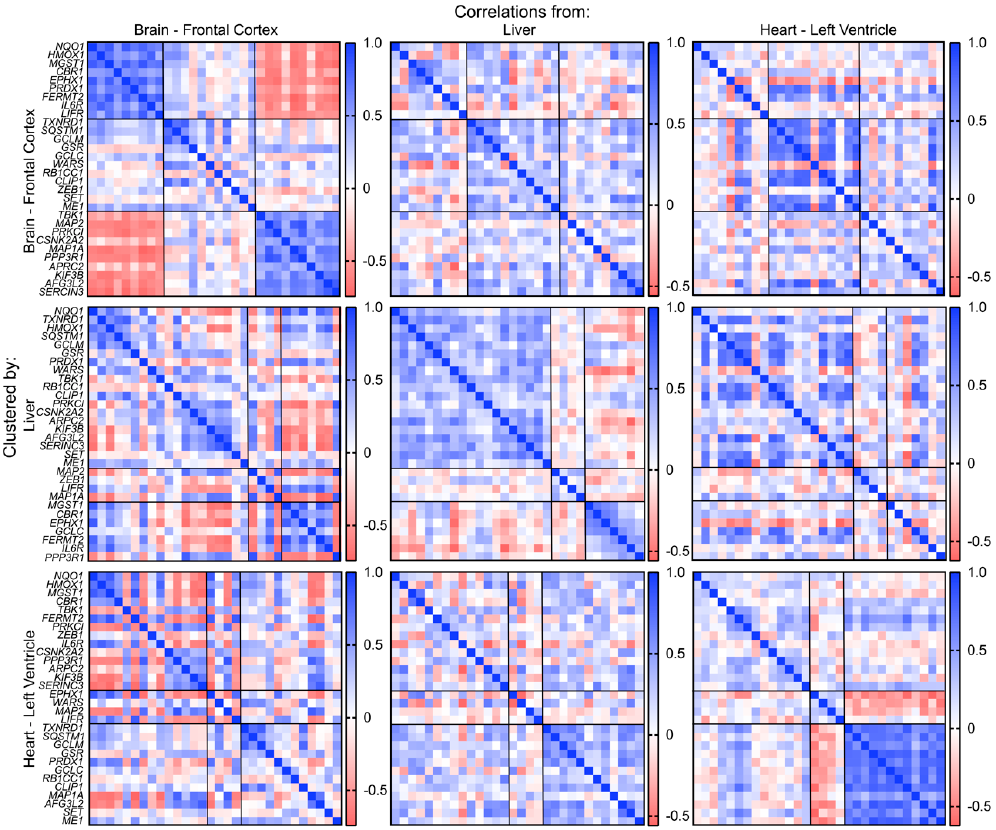
Figure 7. Co-expression patterns of NRF2 target transcripts in human tissues. Genes are separated into three groups by hierarchical clustering. First row: Correlation matrices of brain, liver, and heart clustered by the similarity of correlation patterns in the brain. Second row: Correlation matrices of brain, liver, and heart clustered by the similarity of correlation patterns in the liver. Third row: Correlation matrices of brain, liver, and heart clustered by the similarity of correlation patterns in the heart. Table 1. Correlated and anti-correlated NRF2 target genes in the indicated human tissues. Related to Figure 7. Brain Liver Heart Correlated Anti-Correlated Correlated Anti-Correlated Anti- Correlated Correlated PRKCI